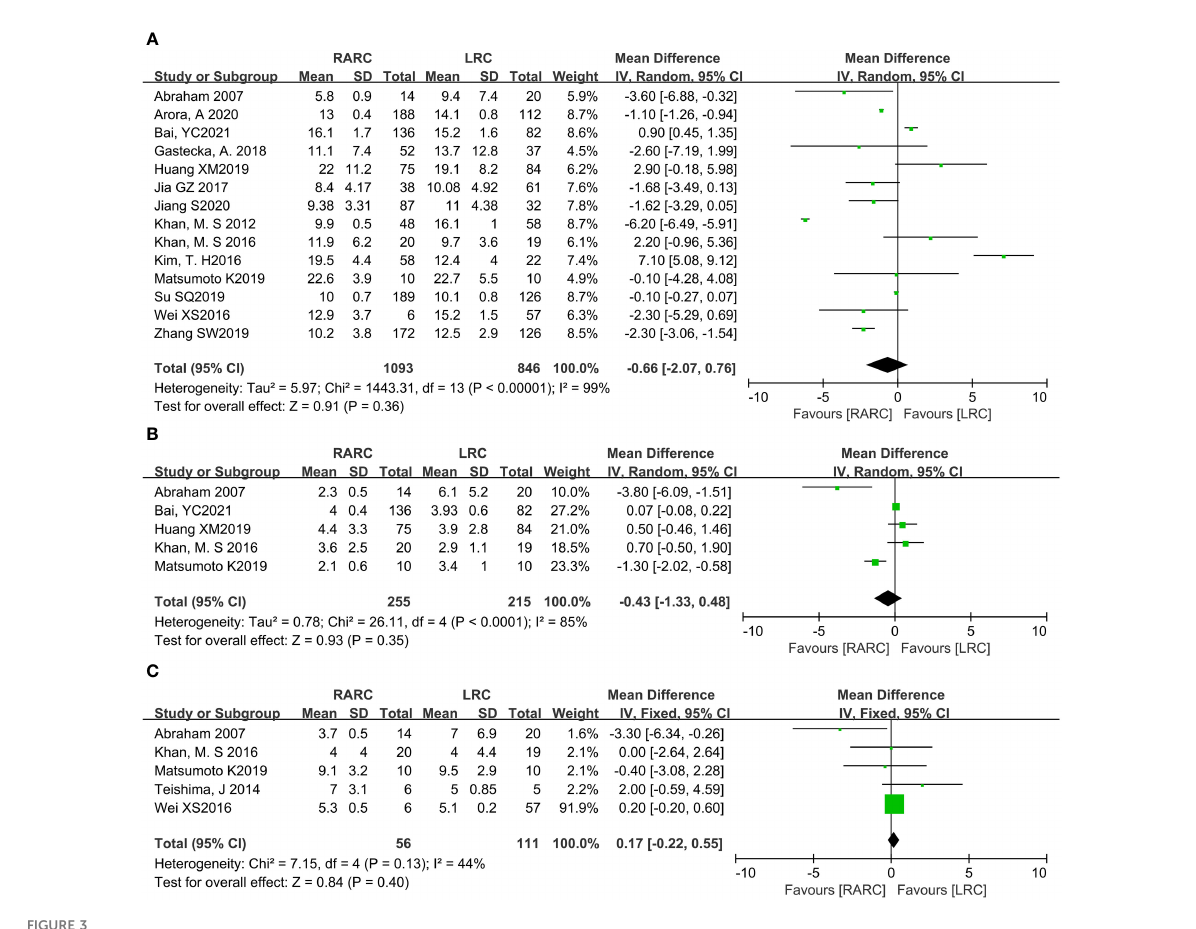
FIGURE 3 Forest plot of RARC versus LRC on (A) Hospital stay, (B) Days to oral intake, and (C) Days to regular